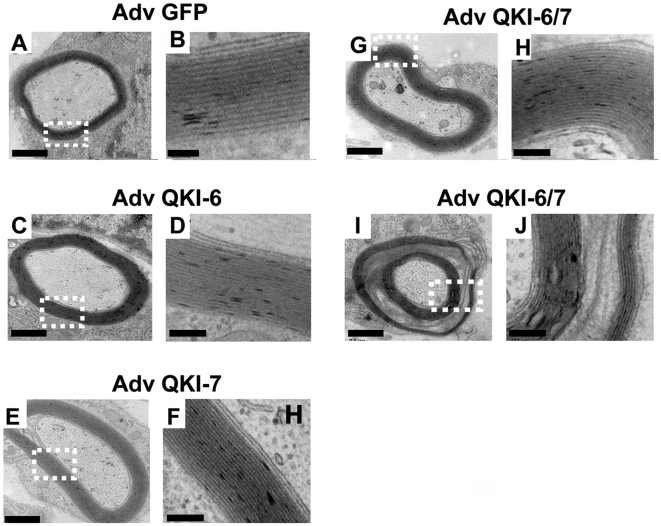
Electron microscopy of the myelin layers of the QKI-transduced Schwann cells/neurons co-cultures.Co-cultures of Schwann cells/neurons were transduced with adenoviruses encoding GFP alone (A and B), QKI-6 (C and D), QKI-7 (E and F), combination of QKI-6 and QKI-7 (G to J). Myelin layers were analyzed using electron microscopy. Each picture is a representative image from 30 different axons for each treatment showing a detailed view of the myelin sheath.